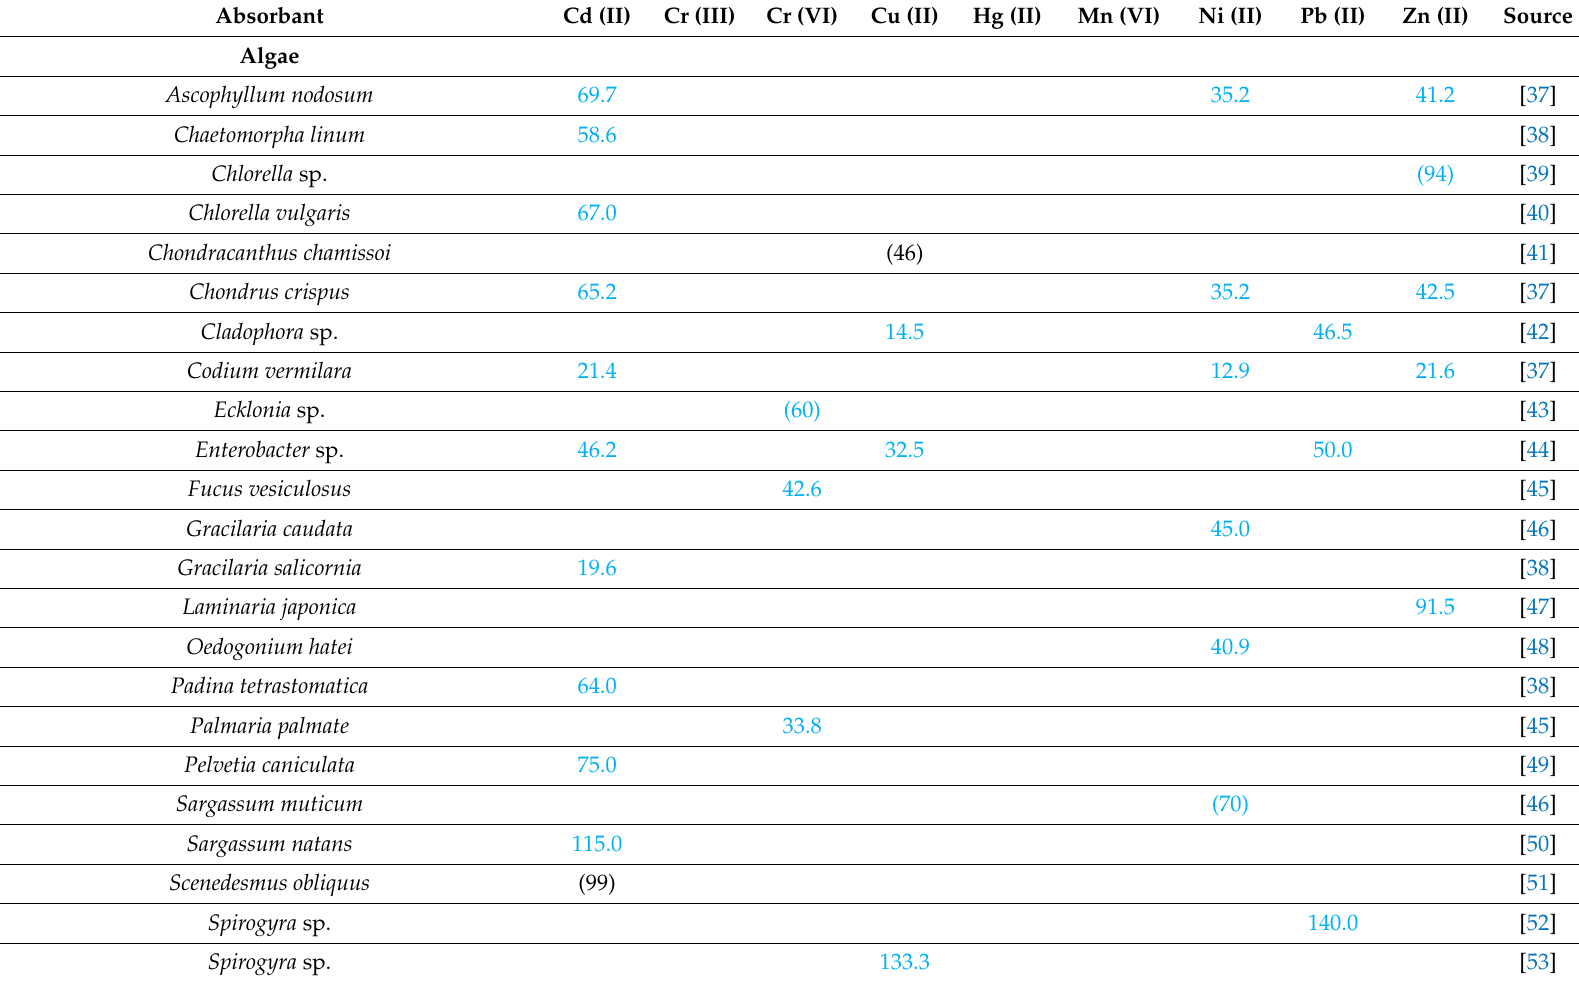
Table 1. Heavy metal removal potential of algae and seashells in the developing world, in mg / g or (% removal) (Peruvian studies in black color). SNS stands for “species not